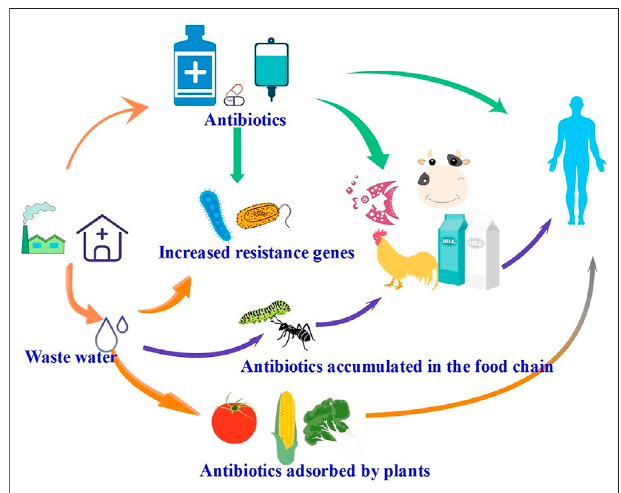
FIGURE 1 | Circulation of antibiotics in the